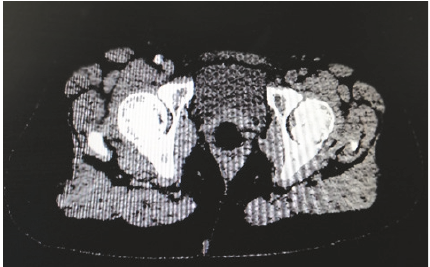
Figure 6: CT angiography revealed dislodgement of aortic throm- bus and occlusion of the left common femoral artery (Absence of contrast agent in the arterial